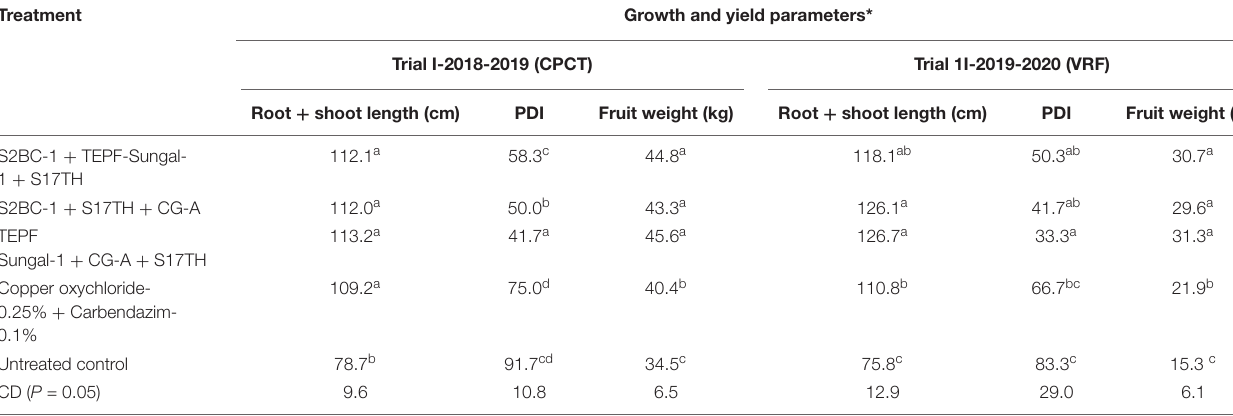
TABLE 4 | Field evaluation of biocontrol agents for management of vascular wilt of tomato. Treatment